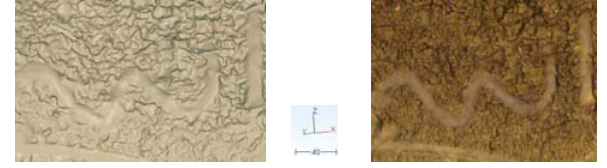
Figure 5. Visualization of the sub-millimetric meshed model (250mm x 160mm) of a clay panel recorded with the FARO ScanArm, with textures